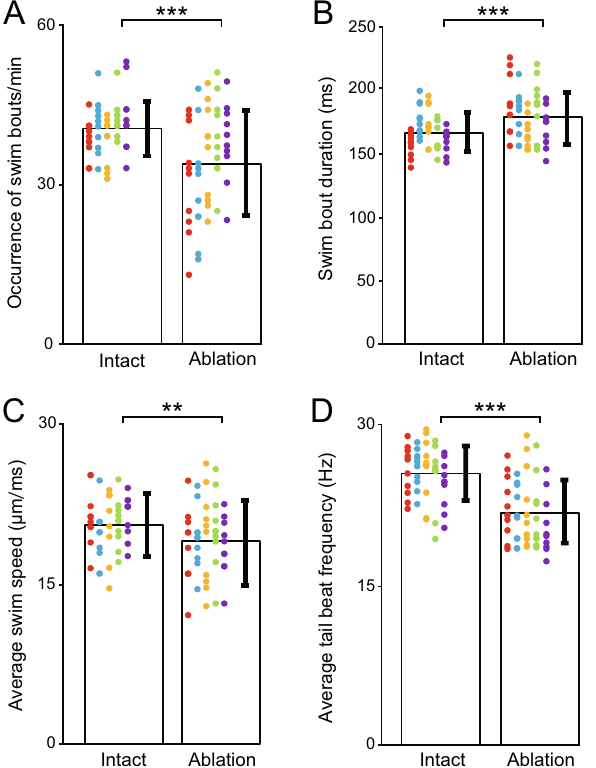
Figure 4. Swim parameters of intact and MCoD-ablated fish. For the analyses of each parameter, five fish were examined for each fish type. For each fish, 10 swim bouts (or a 1-min movie in the case of A ) were examined. Data obtained from the same fish are color coded (the same fish as Fig. 3D,E). ( A ) Occurrence frequency of swim bouts (per minute) of intact and MCoD-ablated fish. ( B ) Swim bout duration of intact and MCoD-ablated fish. ( C ) Average swim speed of intact and MCoD-ablated fish. ( D ) Average tail beat frequency of intact and MCoD-ablated fish. ** p < 0.01, *** p < 0.001 (two-tailed t